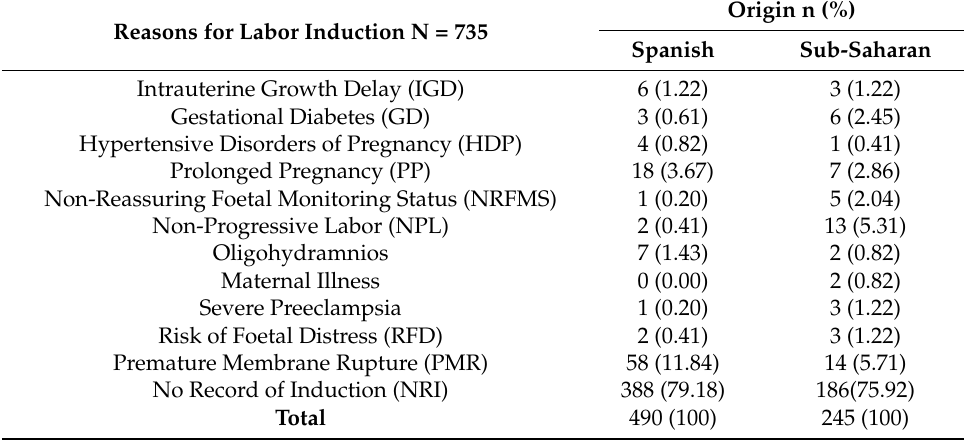
Table 3. Reasons for inducing labour according to